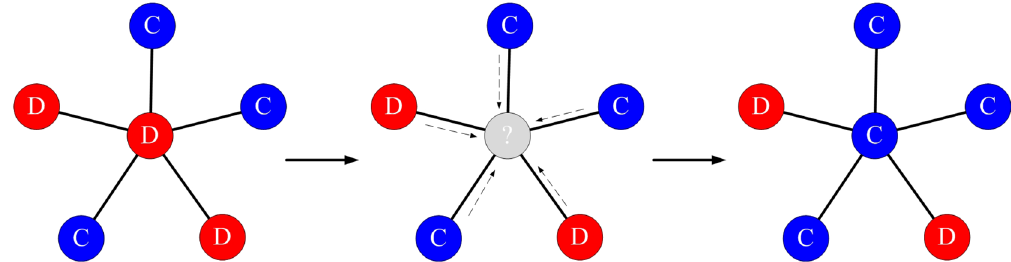
Figure 1. An update step of the model. Each individual occupies the vertex of graph and derives a payoff from the interactions with its neighbours. A random node is selected to die and its place is occupied by one of its neighbours with probability proportional to